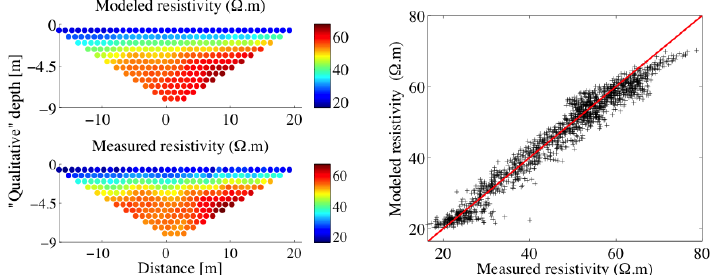
Figure 7. Left panels: an example of “quantitative” plots of the modeled and measured apparent-resistivity data on 8 May 2013. Right panel: comparison of all measured and modeled apparent-resistivity data in a 1:1 plot. The modeled data were obtained from the coupled hydrological-thermal-geophysical